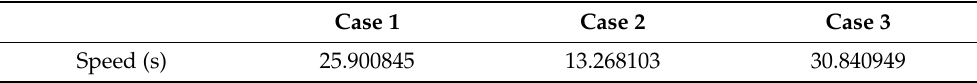
Table 3. Calculation speed and convergence of cases.